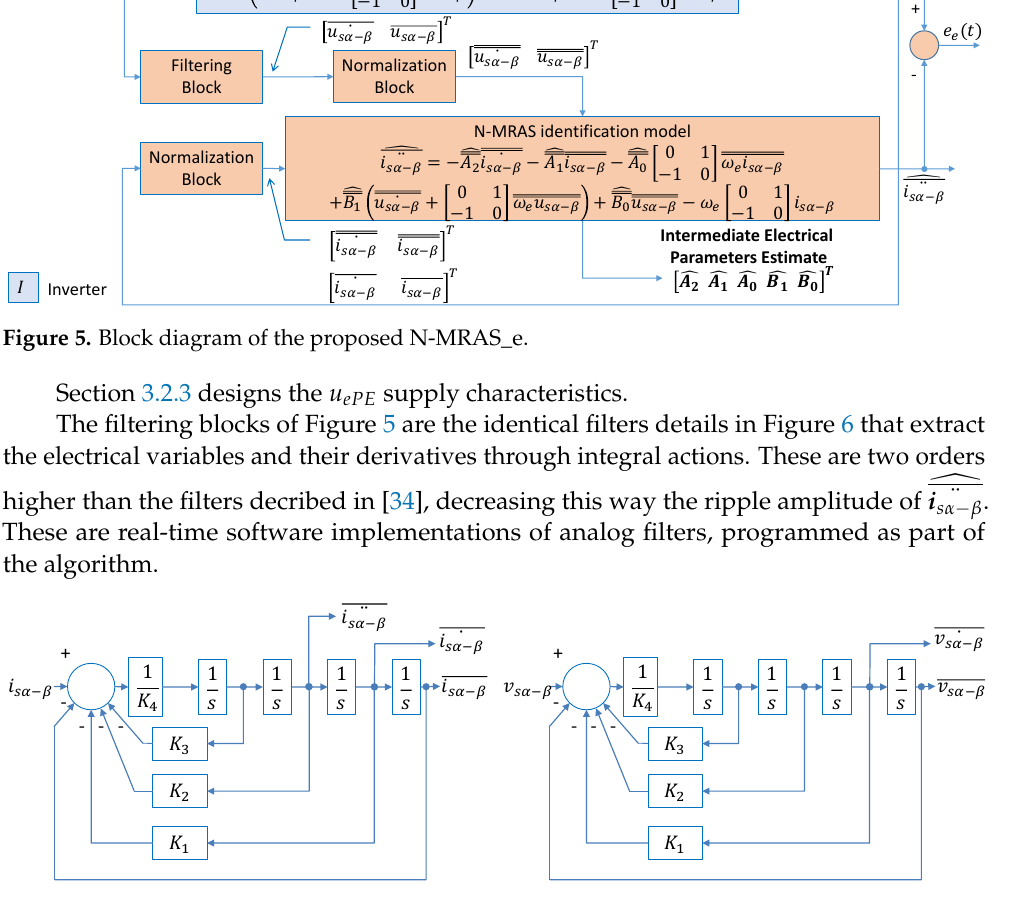
Figure 6. Identical filters of electrical